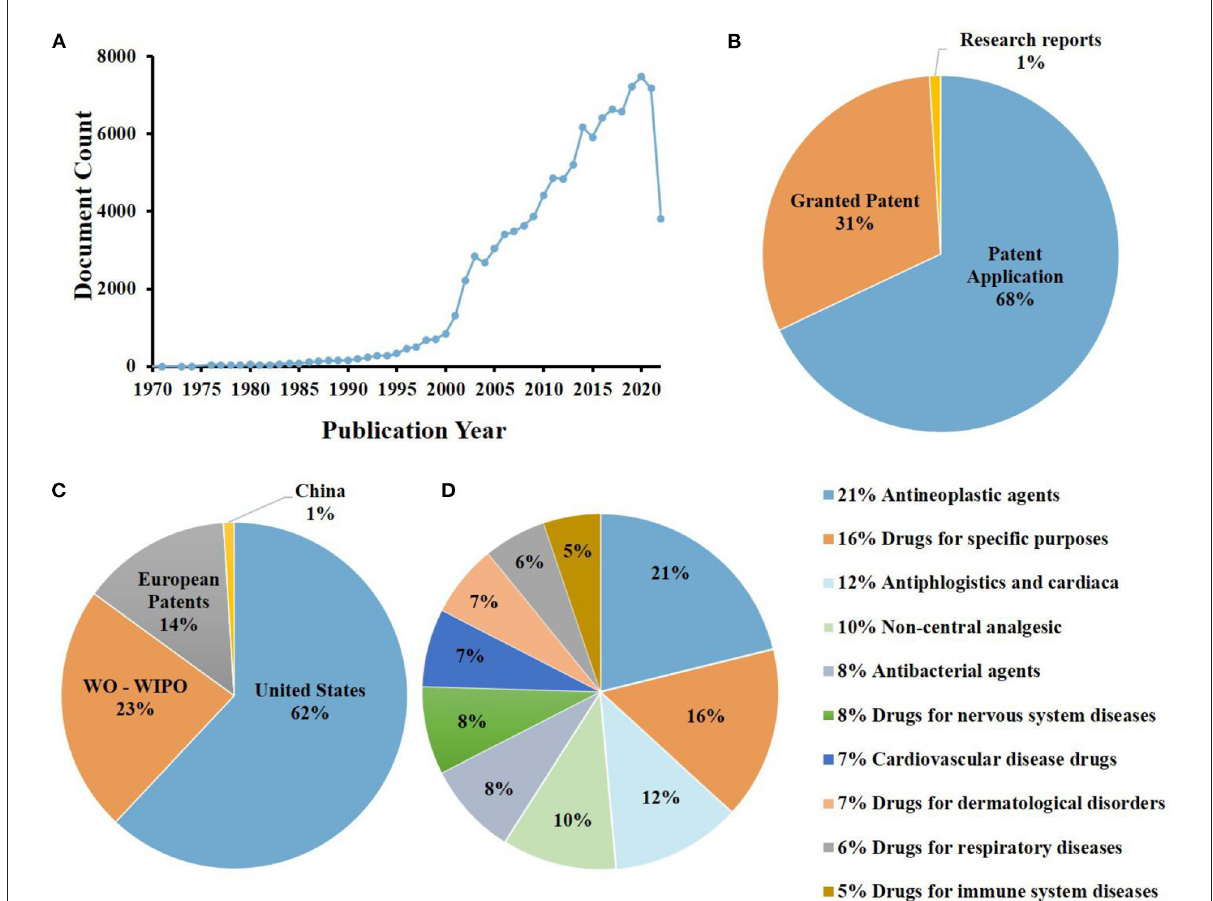
FIGURE4 Analysis of 108,797 patents browsed in www.lens.org using the search terms “Polysaccharide iron complex”: (A) patent applications per years; (B) document type; (C) jurisdictions (WO-WIPO, world intellectual property organization); (D) central product classification.